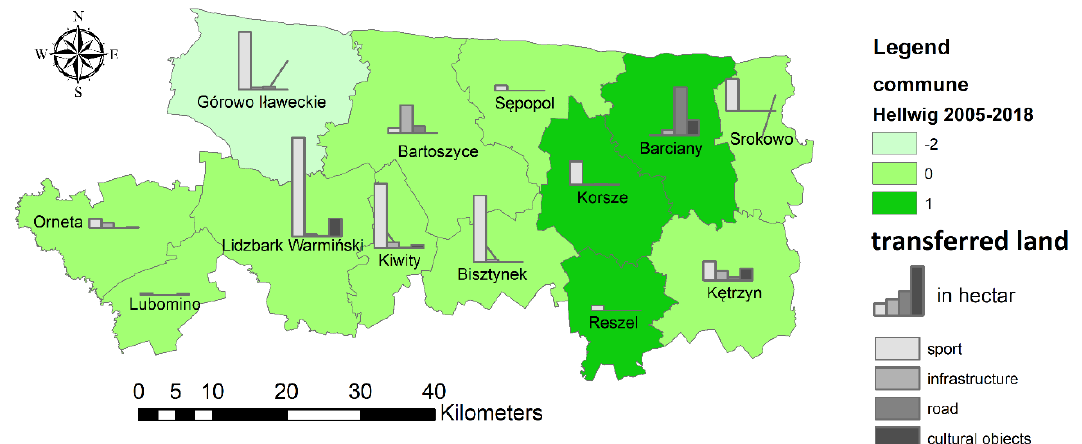
Figure 8. Social development classes for 2018 in comparison with the area of land transferred for various purposes. Data for communes.